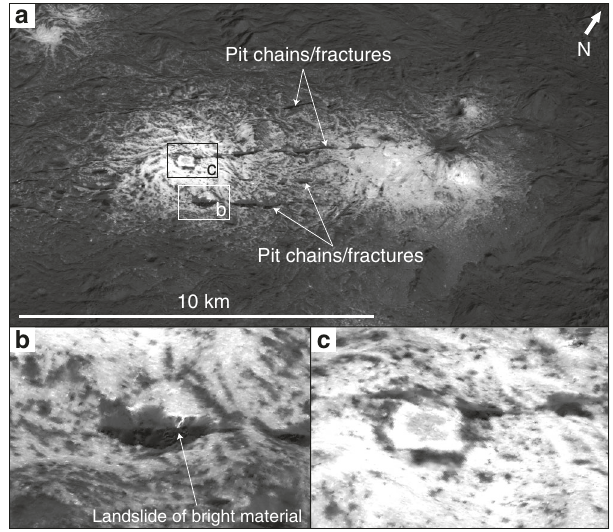
Fig. 4 Perspective views of Vinalia Faculae. a An overview of Vinalia Faculae. The four main pit chains/fractures that cross-cut Vinalia Faculae, and the locations of ( b ) and ( c ), are indicated. The center coordinates of this view are 20° 11 ′ N and 117° 34 ′ W. The ~10 m/pixel XM2 clear fi lter mosaic has 5× vertical exaggeration and to make the perspective view we referenced the mosaic to the LAMO DTM 59 . b A landslide of bright material cascading into a pit chain. c The candidate centralized source